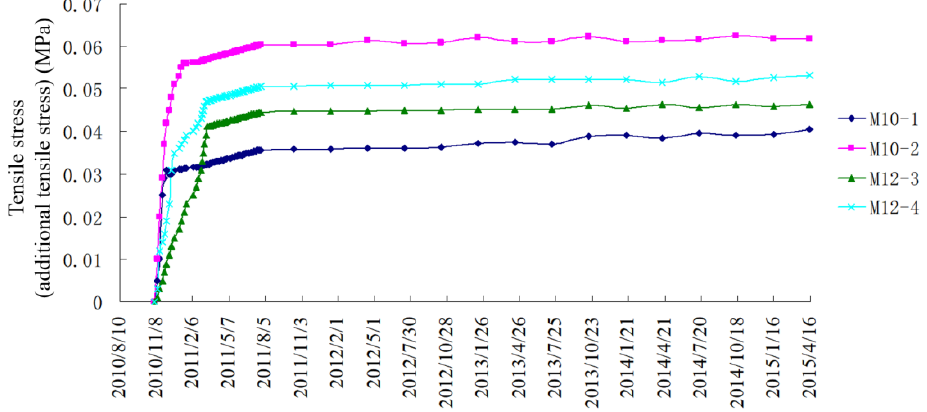
Figure 16. The stress–time curve of each measuring point of fault F4 monitored by the bolt stress meter.